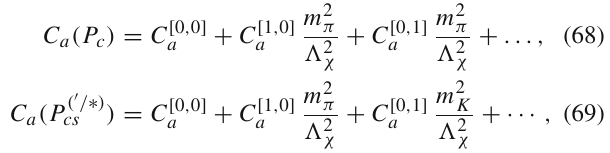
Table 1 Expected masses and hyperfine splitting (in units of MeV) of the J = 1